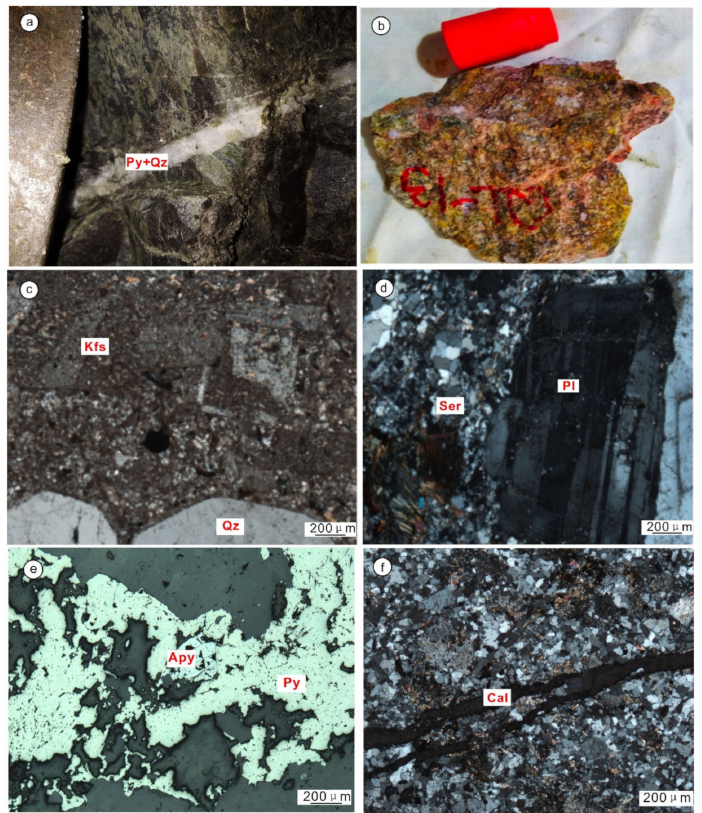
Figure 4. Representative field and microscopic photographs of the Qinglingou Au deposit; scale for ( a ) Quartz–pyrite vein in the mining district; ( b ) Granodiorite porphyry sample from the pit; ( c , d ) Phenocrysts are K–feldspar, plagioclase and quartz, and the matrix is quartz and sericite; ( e ) Arsenopyrite and pyrite vein stage; ( f ) Calcite vein stage. Apy–arsenopyrite; Cal–calcite; Pl– plagioclase; Kfs–Potassic feldspar; Qz–quartz; Ser–sericite;